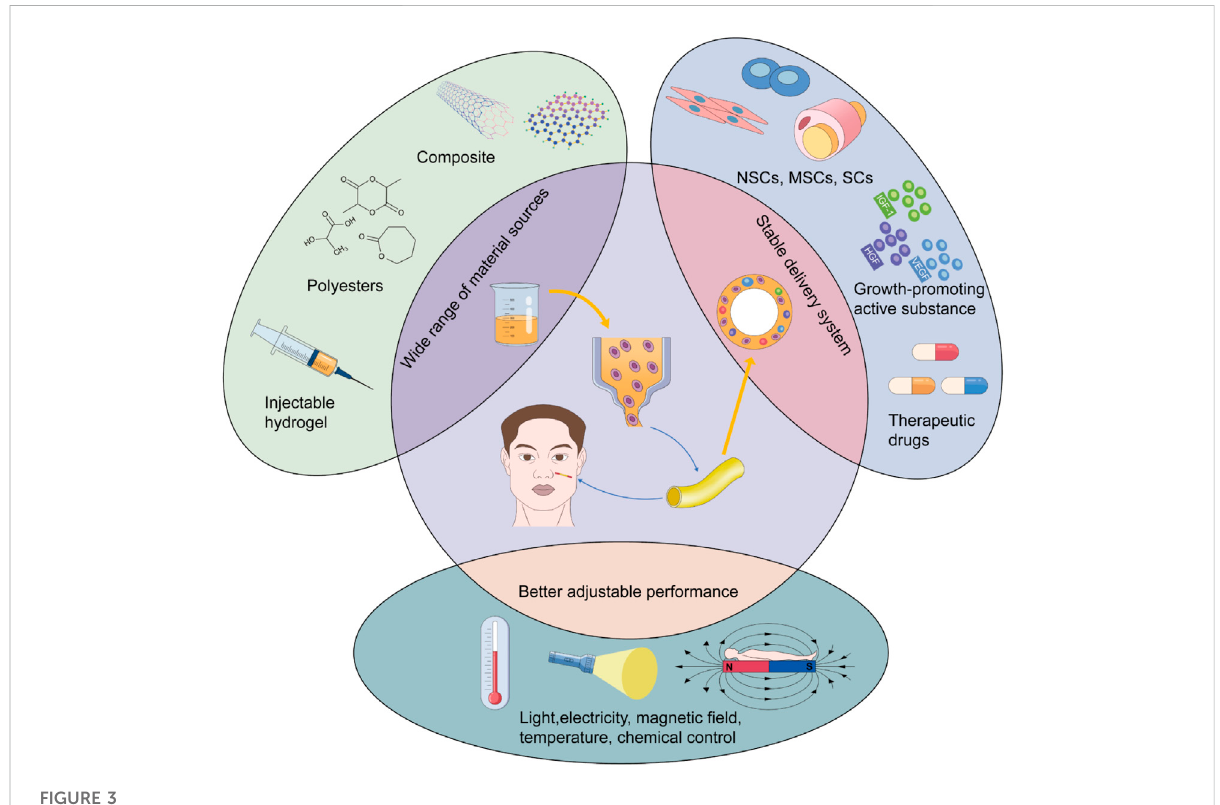
FIGURE 3 Advantages of 3D printing in craniofacial nerve transplantation.